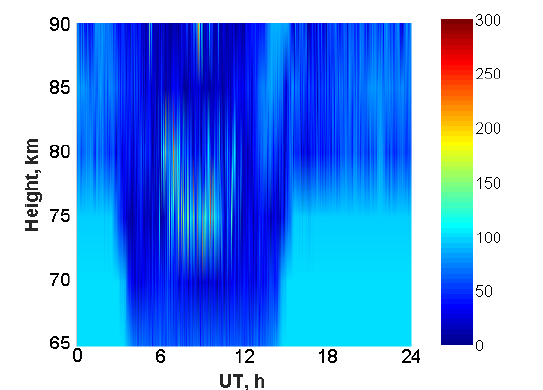
Fig. 8. The calculated relative errors of Ne(h) determination.